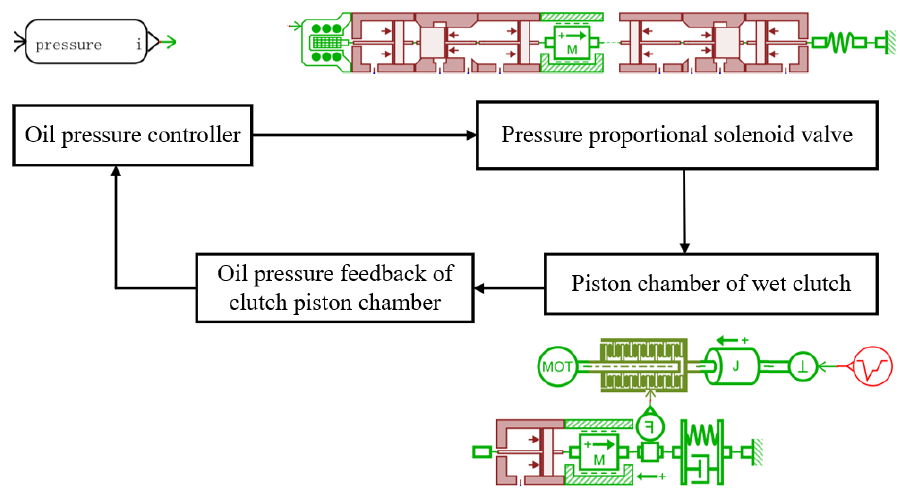
Figure 2. The hydraulic control simulation platform of the wet clutch. The component in red is control signal, components in dark red are hydraulic bodies, components in green are mechanical components, components in dark green are friction plates.